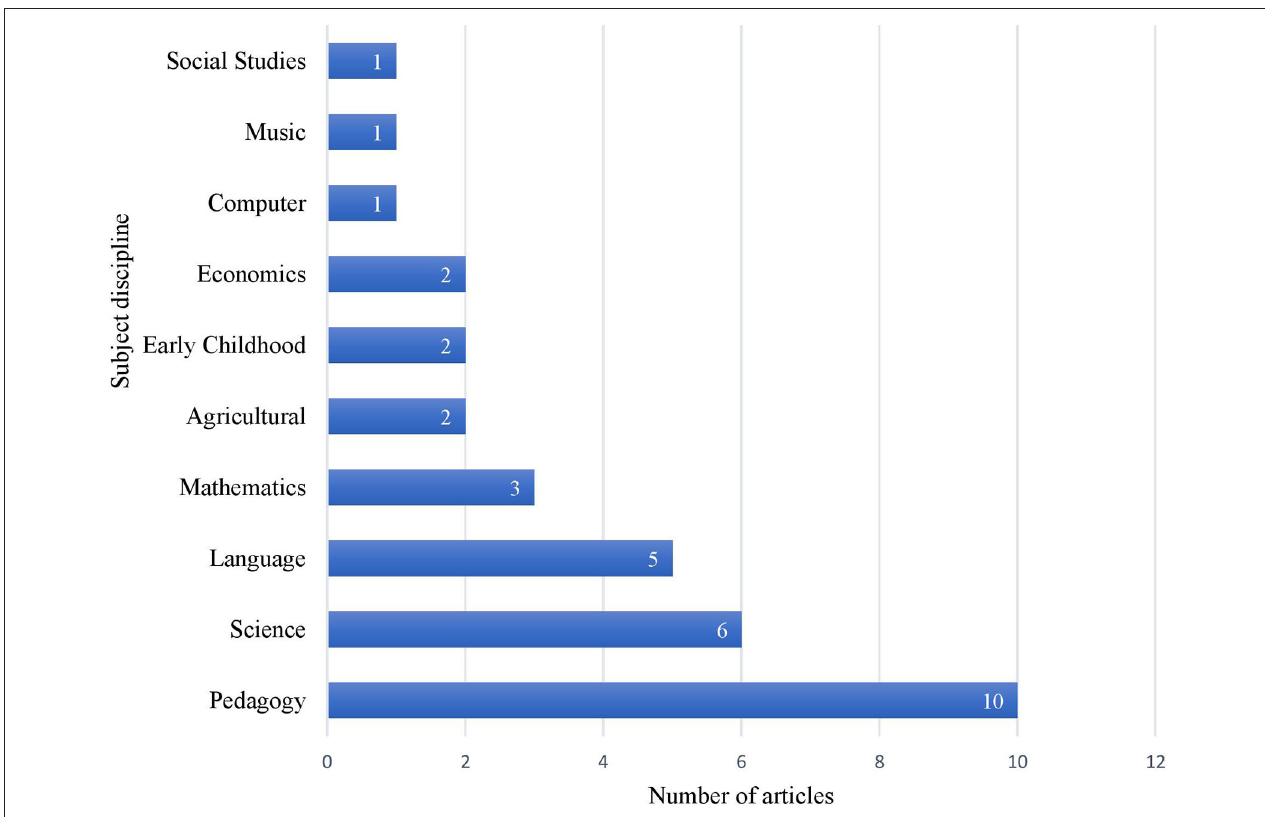
FIGURE 4 | Distribution of studies conducted in different subject disciplines.